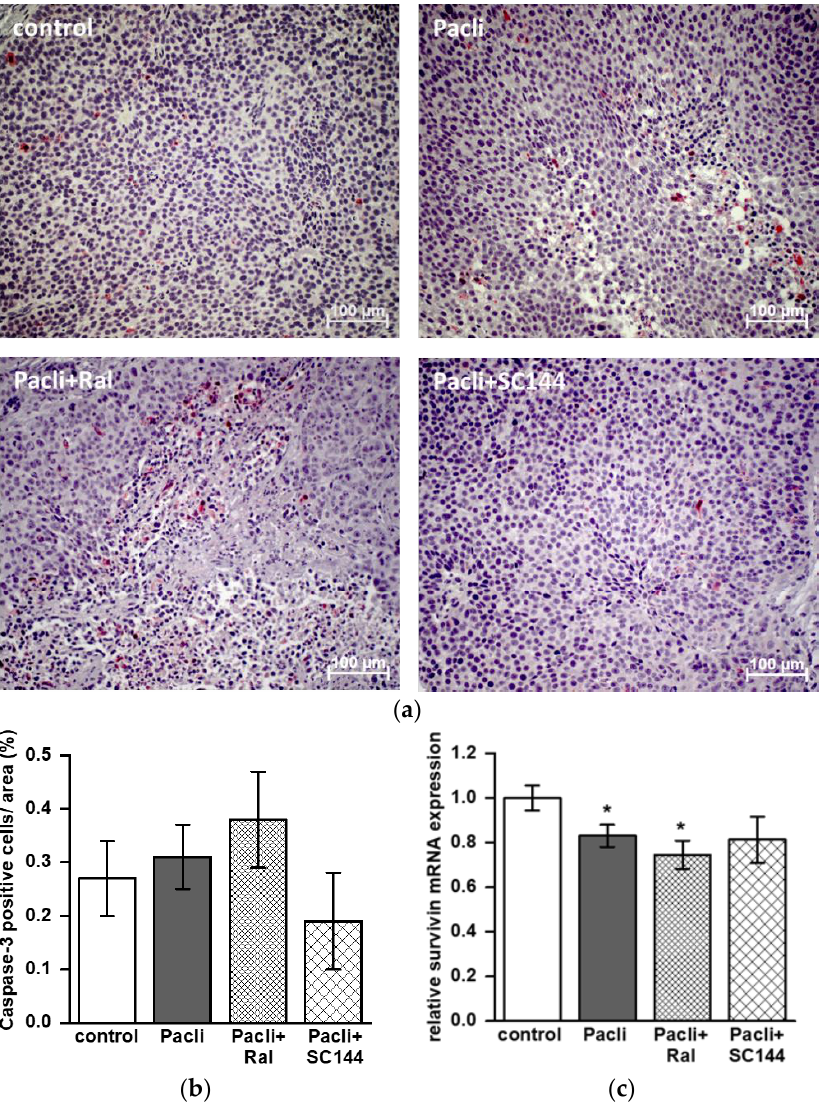
Figure 5. Staining of caspase-3 positive cells of primary mouse tumors and survivin mRNA expression. ( a ) Representative staining of caspase-3 in tumor specimens dissected from control, paclitaxel (Pacli), raloxifene/paclitaxel (Ral + Pacli) and SC144/paclitaxel (SC144 + Pacli) treatment groups. ( b ) Quantification was performed in tumors of n = 5 – 8 mice of each treatment group. Caspase-3 positive cells were counted in at least five consecutive areas of each specimen (20× magnification), and values are given in percent of positive cells per area ± SEM. ( c ) Relative mRNA expression level of survivin in tumor samples (* p < 0.05; Figure 5c).